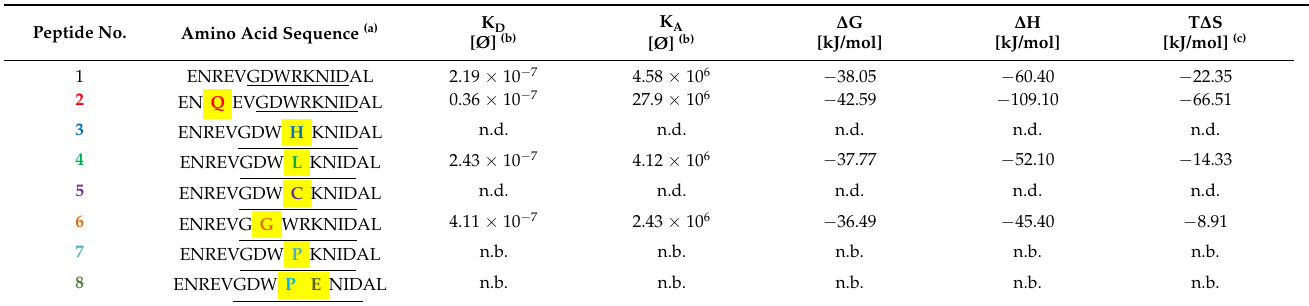
Table 4. Thermodynamic values for immune complex formations of hcTn I epitope peptides and anti-hcTn I antibodies in